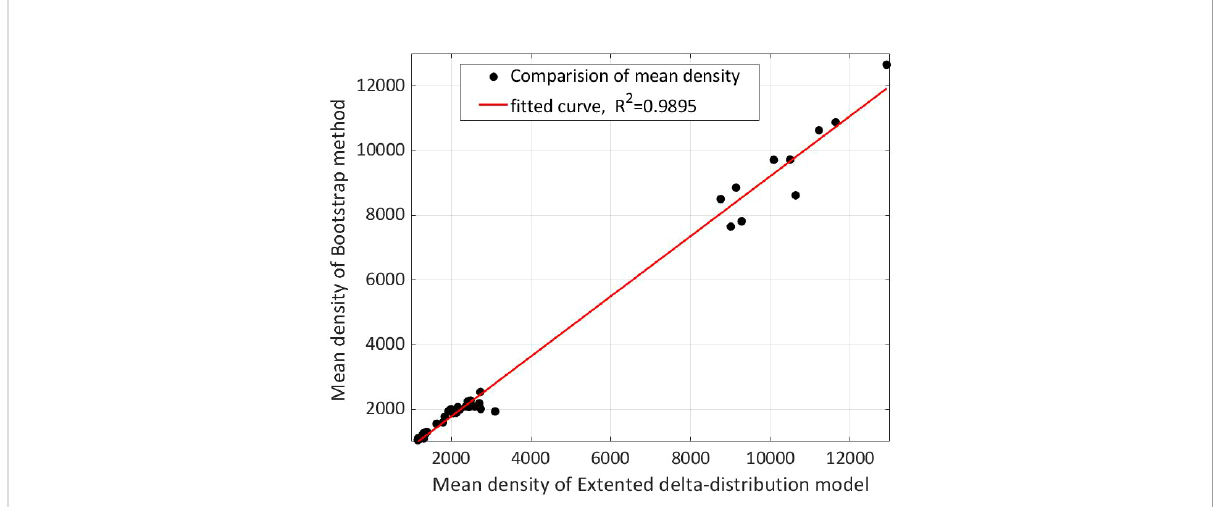
FIGURE 8 Fitting analysis of the simulation results (10 gridding scenarios) between extended the delta-distribution model and the bootstrap